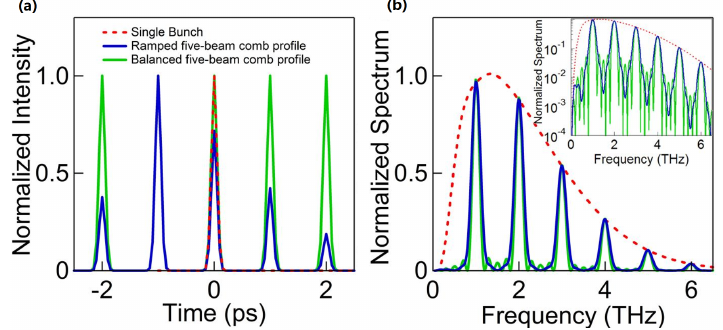
Figure 1. Numerical calculation of terahertz (THz) generation by a train of ps-spaced bunches: ( a ) Bunch profile: single bunch (red dotted line), five-bunch comb beam (green curve), five-bunch comb beam with ramp charge distribution (blue curve). The bunch length is 100 fs, while the comb inter-distance is 1 ps equal to a repetition rate of 1 THz; ( b ) Corresponding generated spectra. Inset: spectra generated in logarithmic